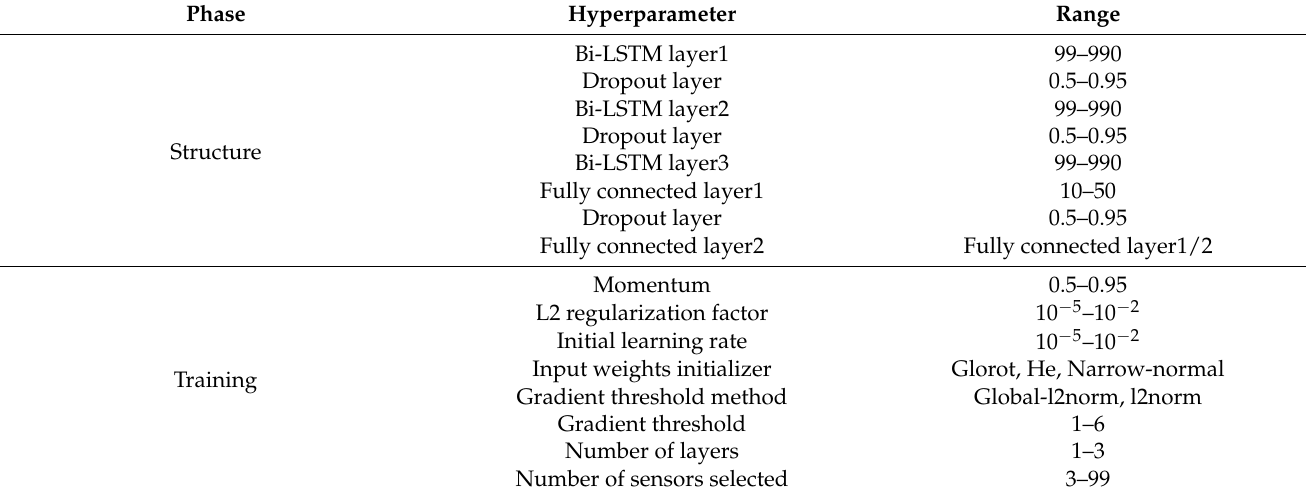
Table 2. LSTM model’s hyperparameters and their structure selected by the Bayesian optimization